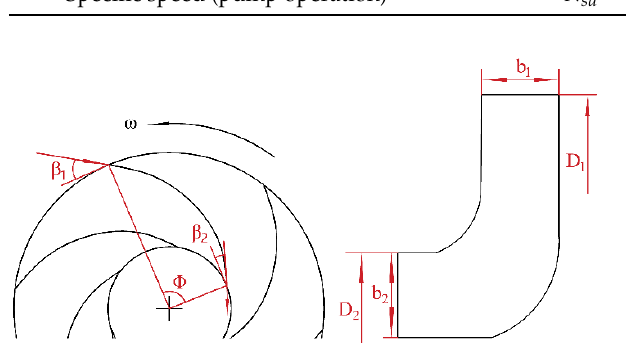
Figure 6. Pictures of the current study’s PAT. Left: front chamber of the impeller; right: back cham- Figure 7. PAT runner diagram. ber of the impeller. Table 1. Geometric parameters and performance parameter of the PAT.